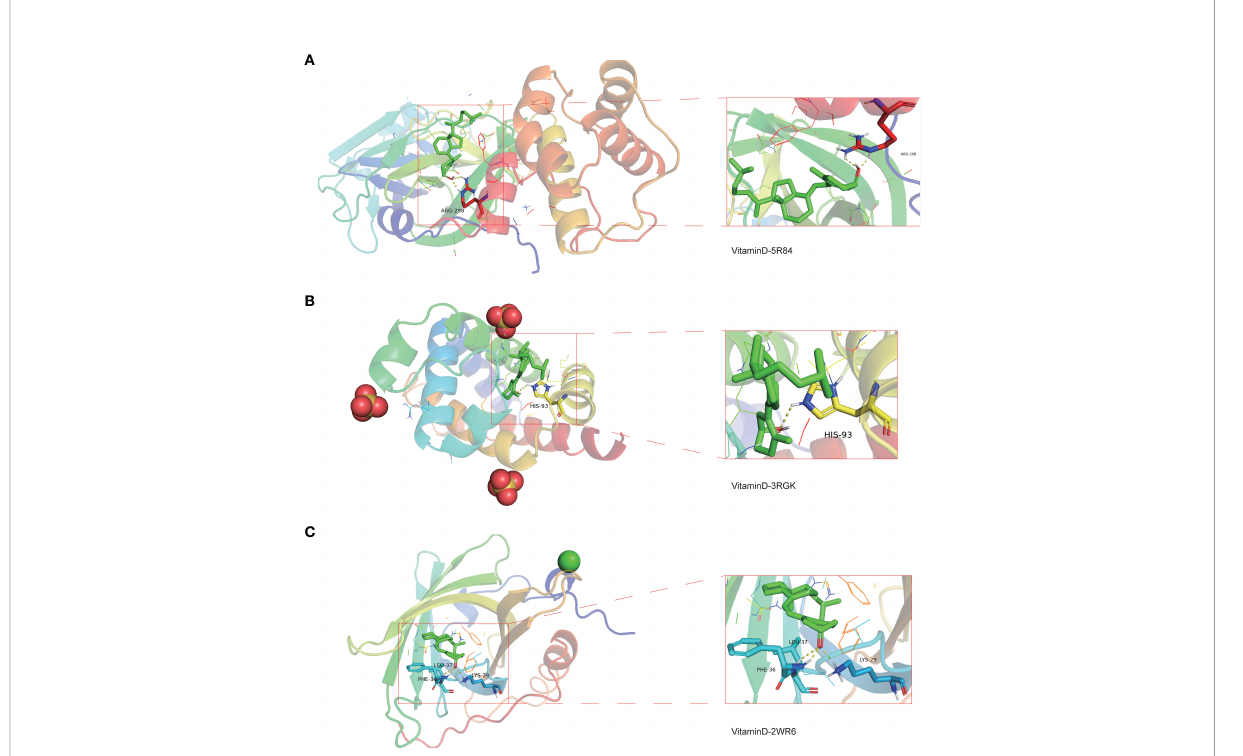
FIGURE 9 Molecular docking analysis for the binding of vitamin D to COVID-19 and the targets MB and RBP4. (A) The binding of vitamin D with SARS- CoV-2 main protease (PDB ID 5R84). (B) The binding of vitamin D with the 3RGK protein of MB. (C) The binding of vitamin D with the 2WR6 protein of RBP4.